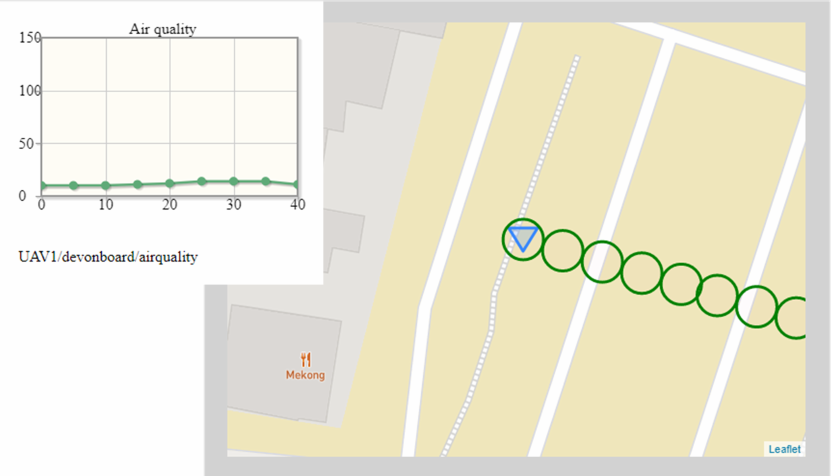
Figure 6. Exemplary situational context (current exhaust gas concentration associated with spatiotem- poral metadata and short-term historical data): good air